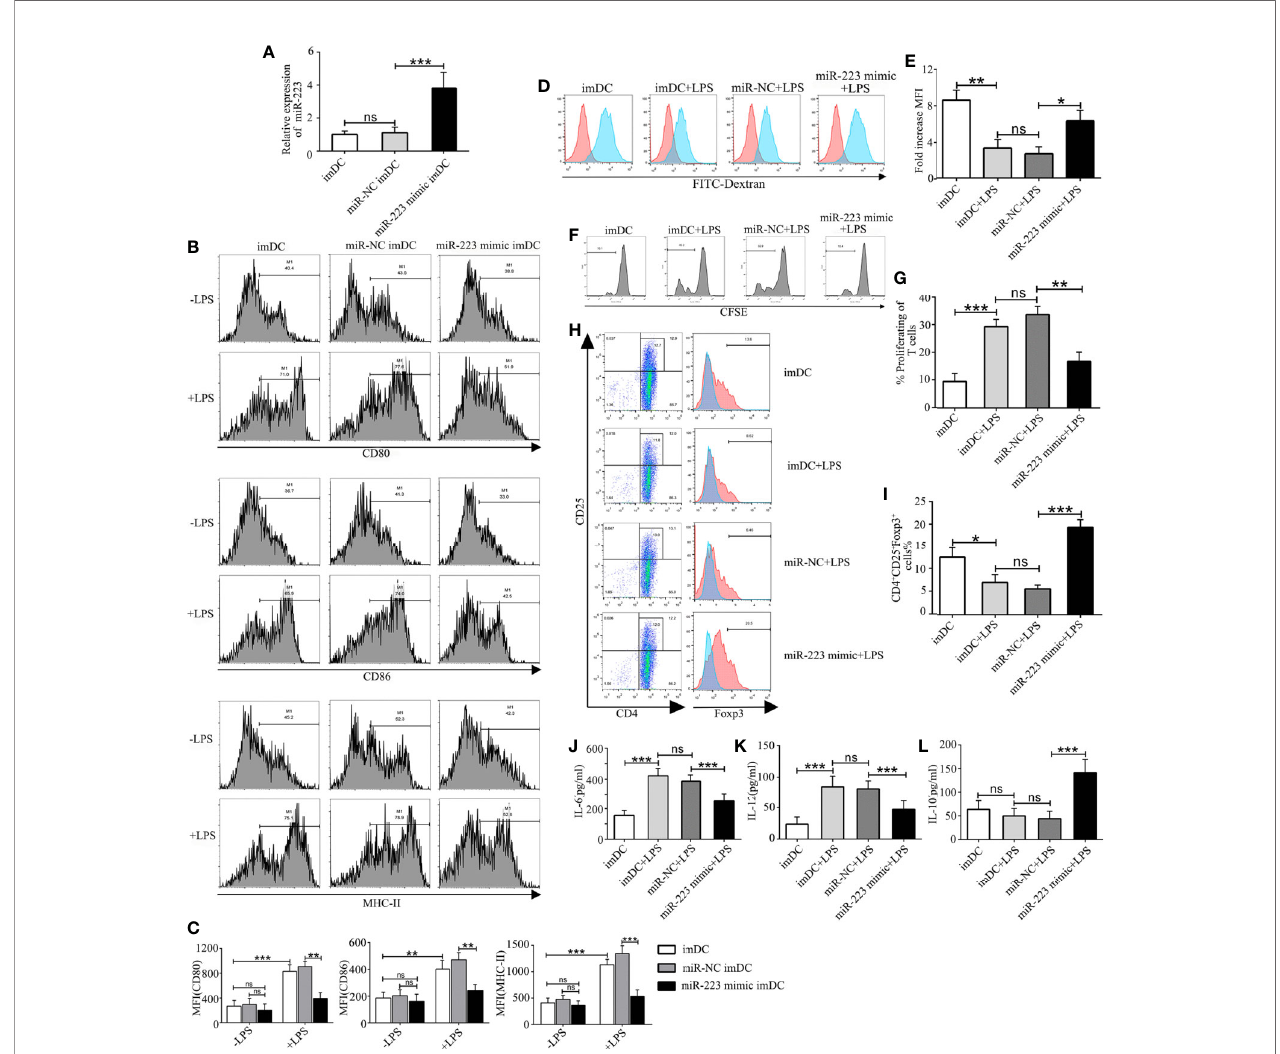
FIGURE 3 | Overexpression of miR-223 promotes tolerogenic properties of DCs. (A) Expression of miR-223 in cells transfected with the miR-223 mimic or the miR- 223 negative control for 48 h (real-time quantitative RT-PCR). (B) imBMDCs, miR-NC-imBMDCs, and miR-223 mimic-imBMDCs were cultured for 12 h in the presence or absence of LPS (100 ng/ml) and then stained with directly conjugated MHC-II, CD86, or CD80 Abs for FACS analysis. (C) Mean fl uorescence intensity. (D) Phagocytic ability of imBMDCs, mBMDCs or miR-NC-imBMDCs, and miR-223 mimic-imBMDCs after LPS stimulation. Phagocytosis of FITC-dextran was measured using FACS. (E) Bar chart indicating the fold-increase in mean fl uorescence intensity in the four groups. (F) Representative FACS results for three independent experiments examining CD4 + T-cell proliferation. (G) Quantitative assessment of CD4 + T-cell proliferation in the four groups. (H) Representative FACS results of three independent experiments for the percentage of Tregs. (I) Quantitative assessment of the percentage of Tregs in the four groups of Tregs. (J – L) Production of cytokines (IL-12, IL-6, IL-10) was analyzed by ELISA in supernatants from BMDC cultures in which imBMDCs, miR-NC-imBMDCs, and miR-223 mimic-imBMDCs were cultured for 12 h in the absence or presence of LPS (100 ng/ml). Data are presented as mean ± SD and represent three experiments. *P < 0.05; **P < 0.01; ***P < 0.001; ns, not signi fi